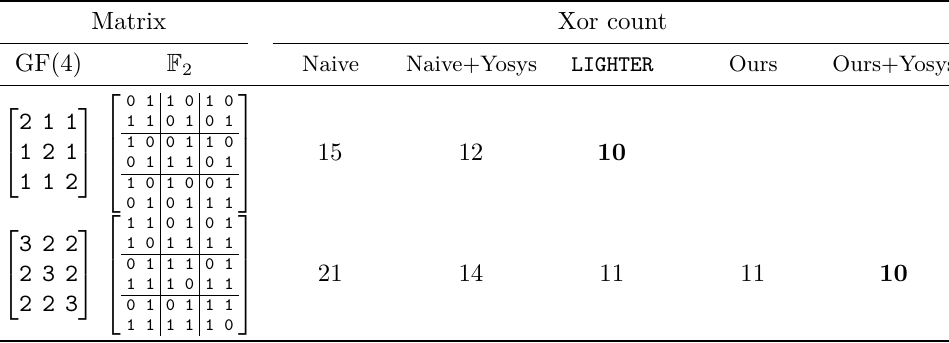
Table 2: Comparison of metrics. Results shown as “+Yosys” have been optimized with synthesis tool Yosys (using ABC as a